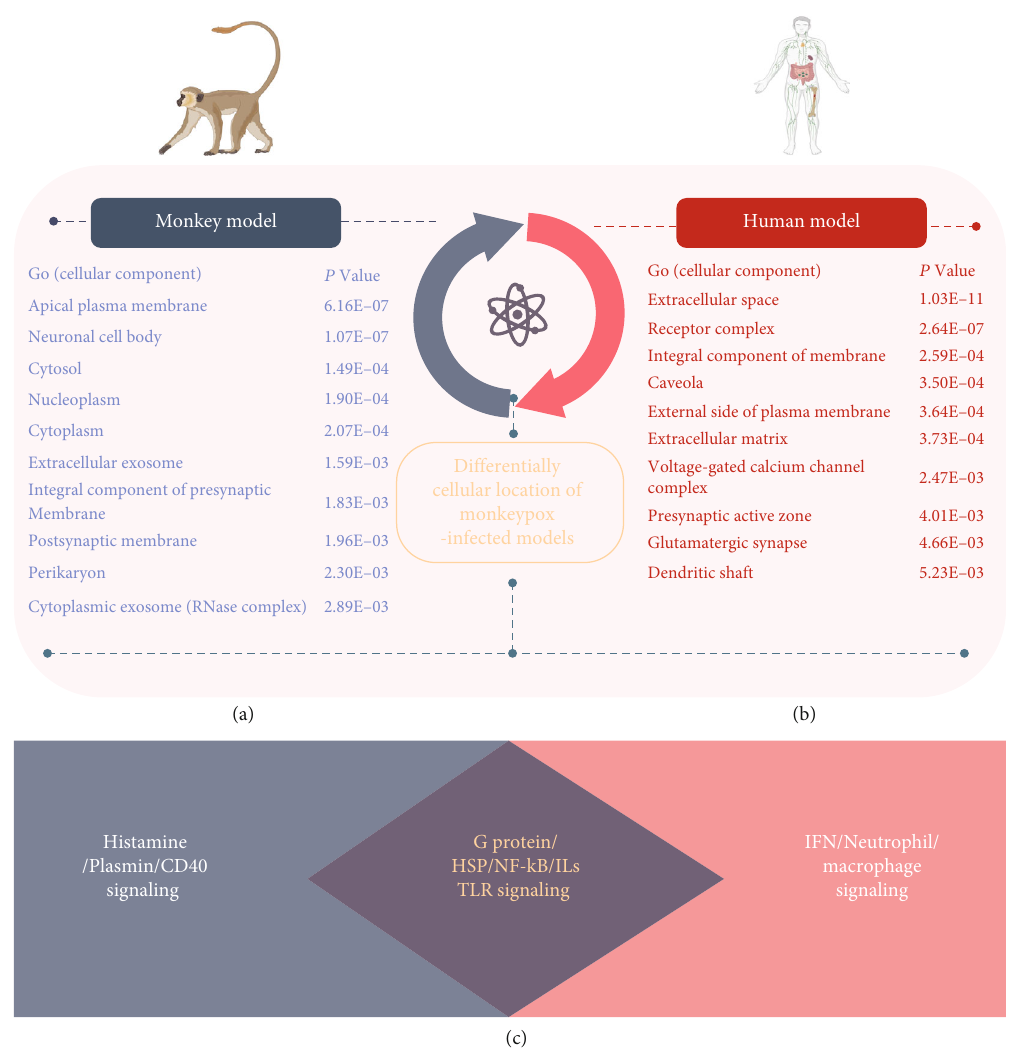
Figure 5: Major characteristics of Gene Ontology (GO) and cellular component annotations are inferred from highly expressed genes shared by the monkeypox-infected Macaca mulatta kidney epithelial (MK2) cell model and the human immortal epithelial cancer (HeLa) cell model. (a) Top highly enriched GO cellular components in the MK2 model. (b) Top highly enriched GO cellular components in the HeLa model. (c) Conclusion of enriched maps discovered by bioinformatic analysis of upregulated genes from the MK2 and HeLa models. The data revealed that interleukins (ILs), G protein-coupled receptors (GPCRs), heat shock proteins (HSPs), Toll-like receptors (TLRs), and metabolic-related pathways were the elevated expression of both monkeypox-infected monkey and human cell lines. Besides, cluster of di ff erentiation 40 (CD40), plasmin, and histamine serve as major regulators in the monkeypox- infected monkey cell line model, while interferons (IFNs), macrophages, and neutrophil-related signaling dominate the monkeypox- infected human cell line